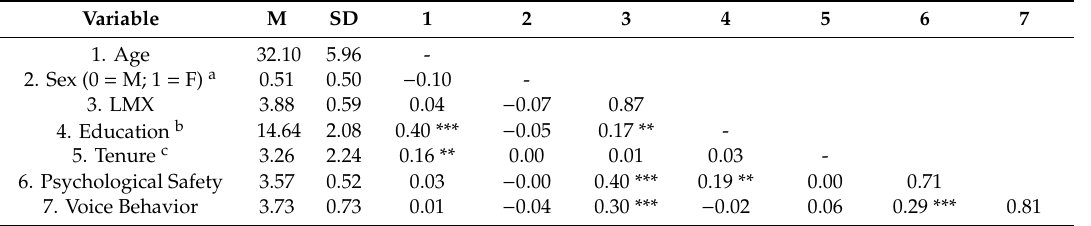
Table 1. Means, standard deviations, correlations, and